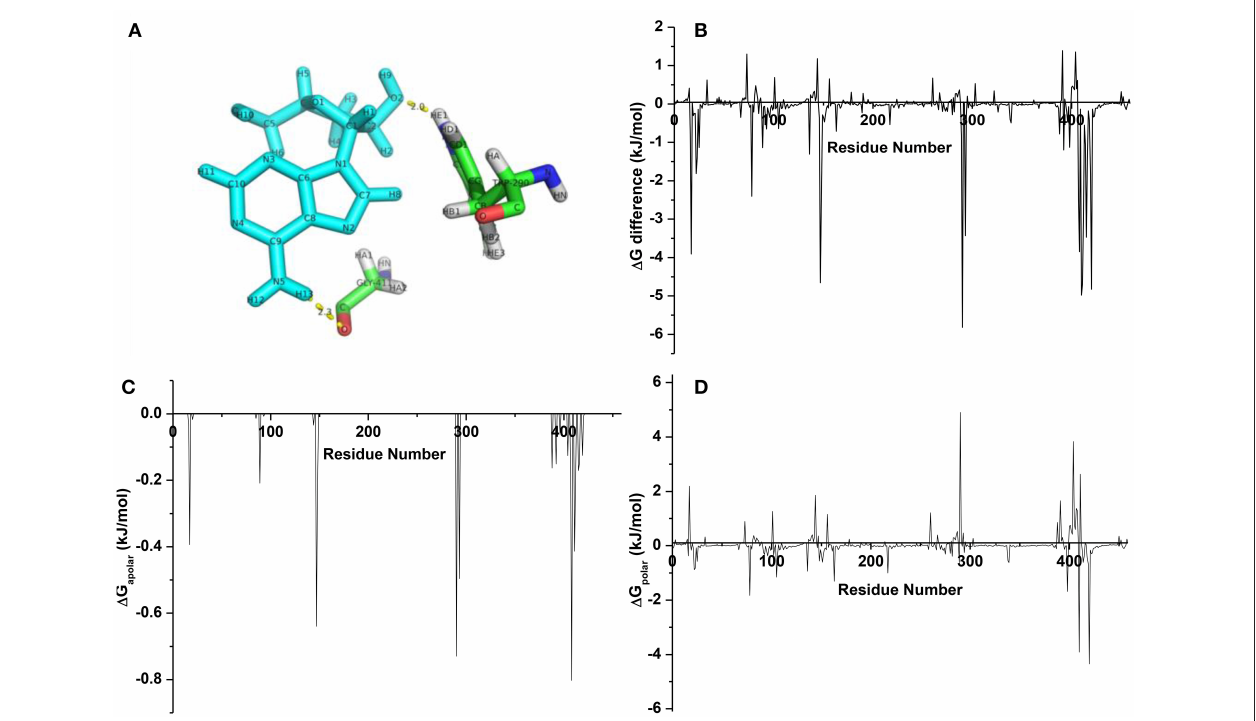
FIGURE 9 | (A) The averaged structure for complexes URAT1-cordycepin; (B) energy difference of each residue for cordycepin; (C) nonpolar interaction spectra; (D) polar interaction